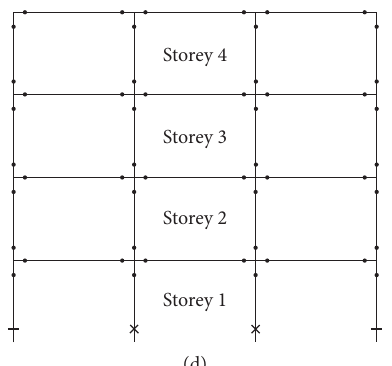
Figure 9: Damage states of the original and FRP-retrofitted frames. (a) Damage of original frame subjected to mainshocks. (b) Damage of original frame subjected to mainshock-aftershock sequences. (c) Damage of GFRP-retrofitted frame subjected to mainshocks. (d) Damage of GFRP-retrofitted frame subjected to mainshock-aftershock